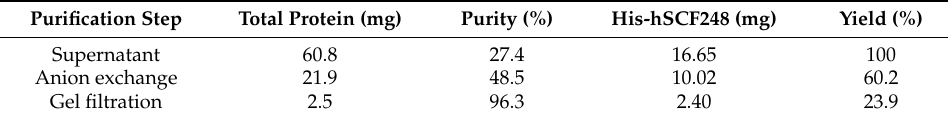
Figure 4. Purification of full-length His-hSCF248 from E. coli . ( a ) Flow chart of the purification steps. AEC, anion-exchange chromatography; GFC, gel filtration chromatography. ( b ) His-hSCF248 was purified using AEC and GFC. M, molecular weight size marker; lane 1, total cell proteins before IPTG induction as negative; lane 2, total proteins induced by IPTG after cell sonication; lane 3, soluble proteins after cell sonication from total cell proteins; lane 4, His-hSCF248 (31.9 kDa) purified with AEC; lane 5, concentrated His-hSCF248; lane 6, His-hSCF248 purified with GFC. Table 4. The purification yields of